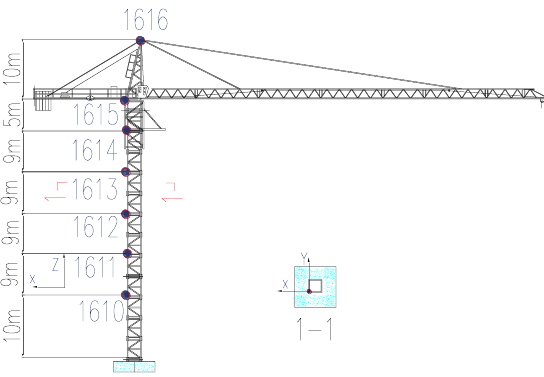
Figure 4. Instrument layout and its coordinate system.